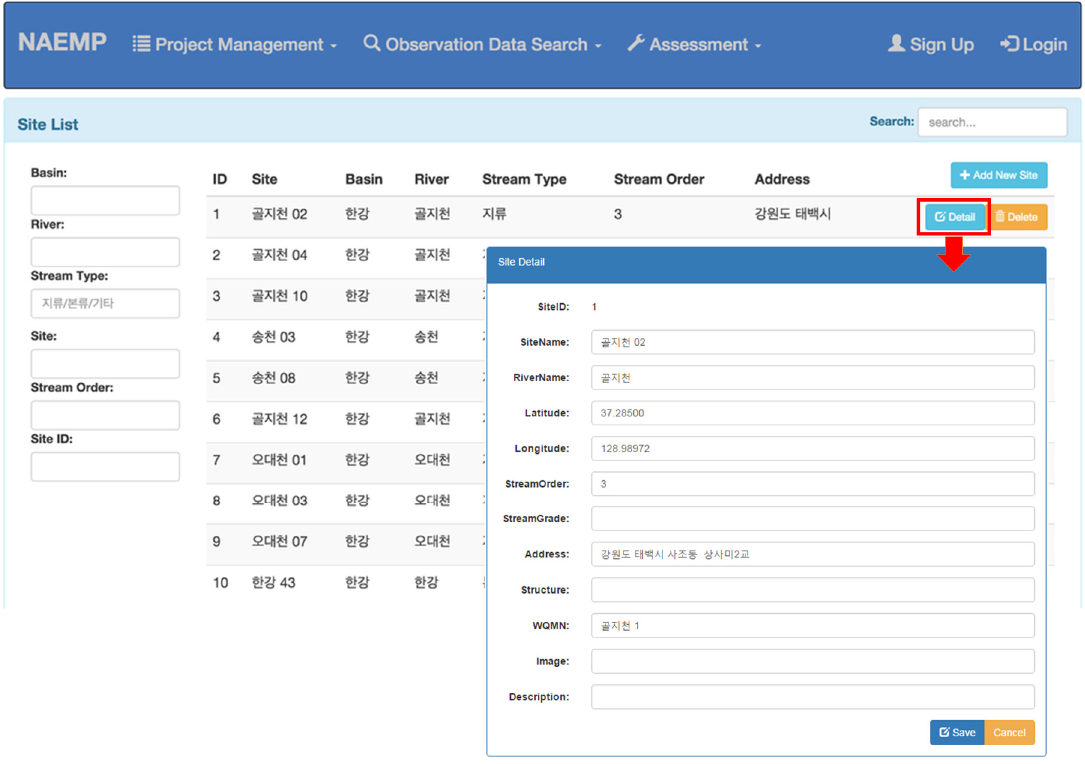
Figure 41. GUI window for the detailed view and update for a site. Figure 11. GUI window for the detailed view and update for a